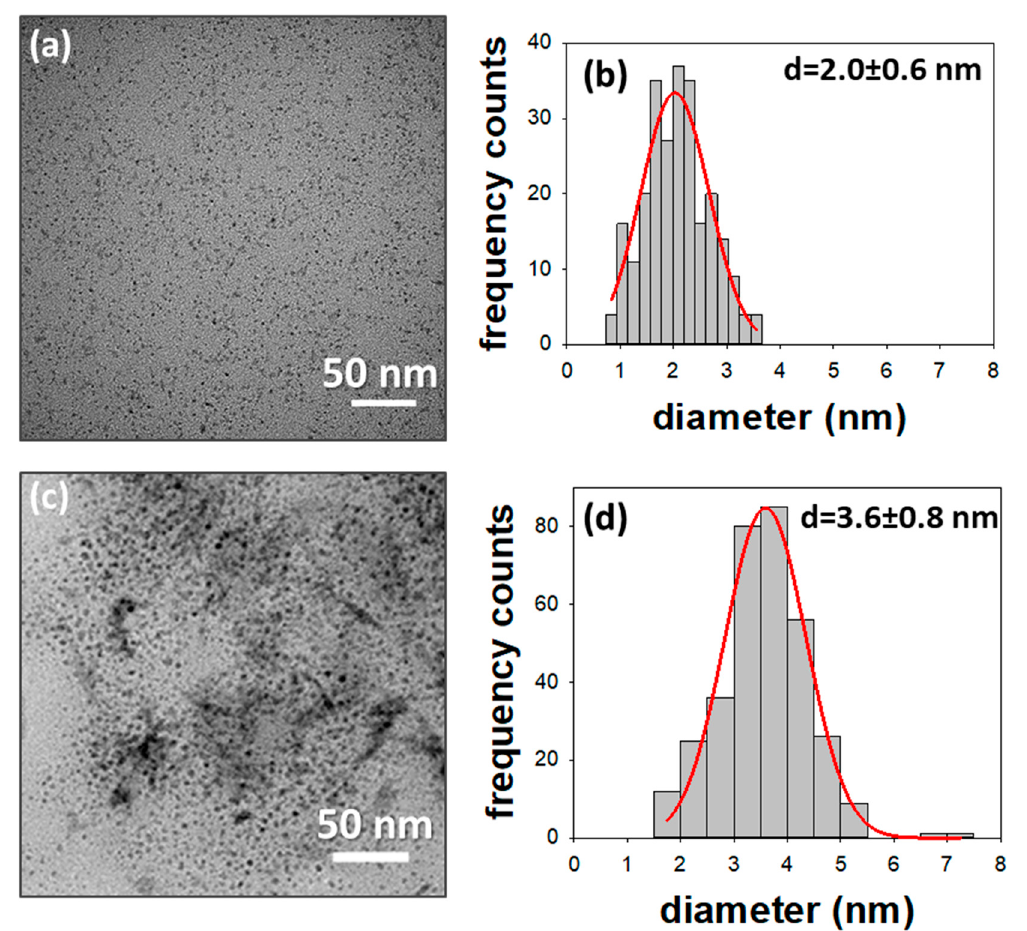
Figure 2. Transmission electron microscopy (TEM) images of the Cu@TDoAC colloid ( a ), and the Cu@BDHAC colloid ( c ), along with the size distribution histograms ( b , d ). Sample ( a ) d = 2.0 ± 0.6 nm, n = 250; sample ( c ) d = 3.6 ± 0.8 nm, n =